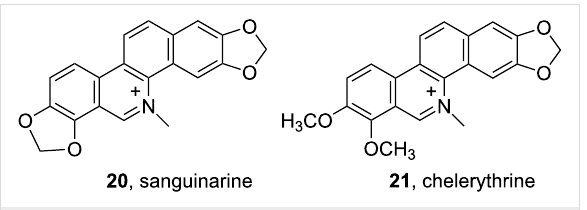
Figure 12: Examples of naturally occurring phenanthridine